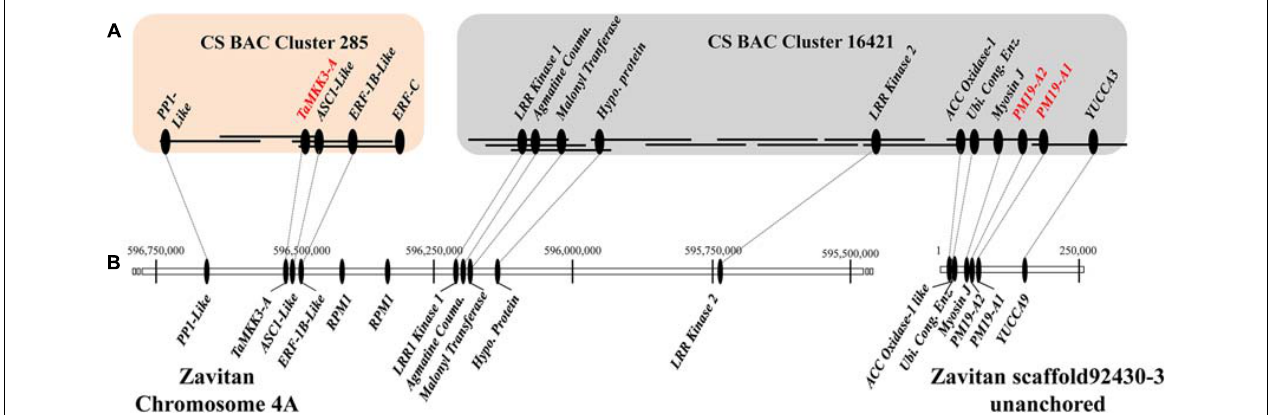
FIGURE 1 | Physical map of the Phs-A1 interval in bread wheat Chinese Spring (CS) and wild emmer (Zavitan). (A) Phs-A1 interval in CS is covered by two non-overlapping BAC clusters: Cluster 285 (4 BACs) and Cluster 16421 (11 of the 20 MTP BACs). BACs are represented by solid lines while genes found on the BAC are represented by filled ovals. The proposed candidate genes for Phs-A1 are in red font. (B) Whole genome assembly of Zavitan wild emmer across the Phs-A1 interval. Genes present in both assemblies are joined by dotted